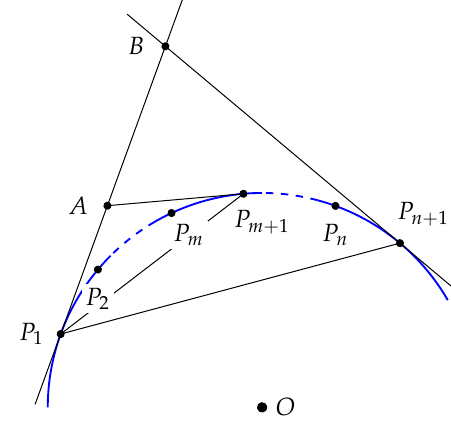
Figure 3. Comparing edge lengths associated to different numbers of congruent